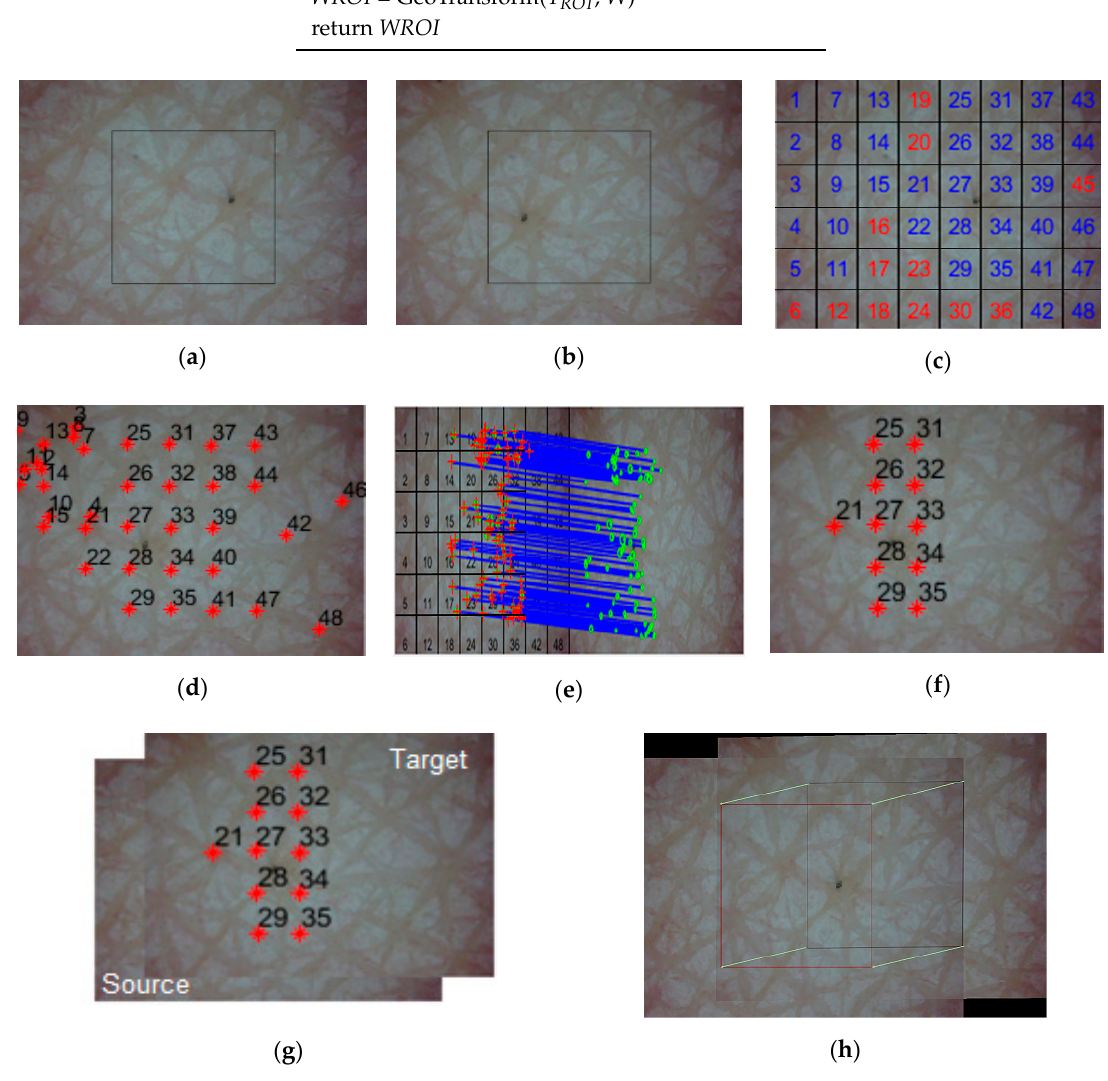
Figure 1. Examples of skin texture mapping step—( a ) source image; ( b ) target image; ( c ) N grid partitioning; ( d ) grid mapping; ( e ) SIFT feature matching on K grids; ( f ) NCC matching on target image; ( g ) overlapped the mapped grids; ( h ) warped